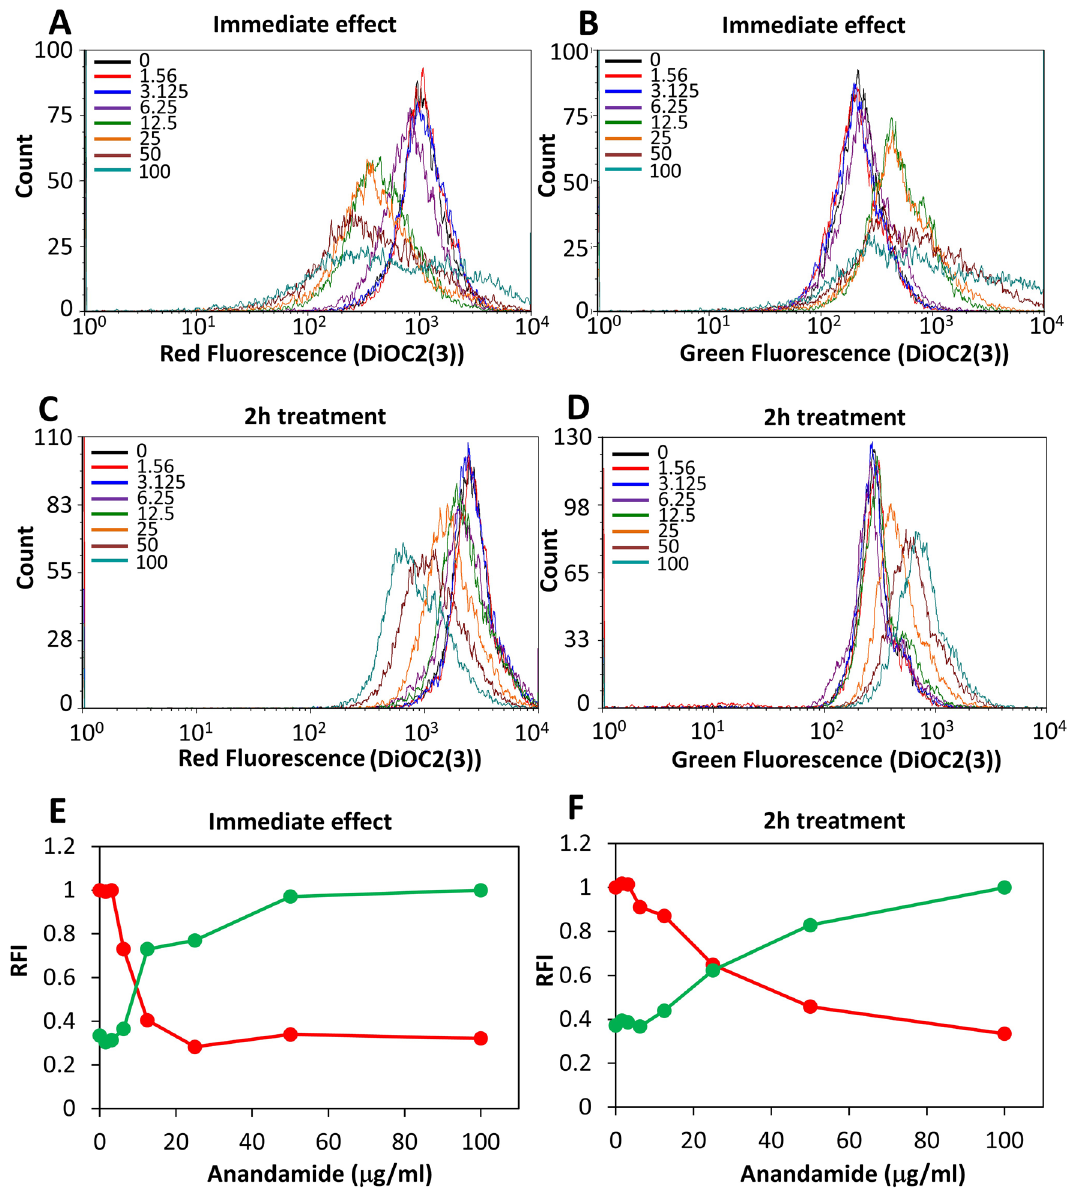
Figure 8. AEA causes an immediate drop in membrane potential that was partially relieved after 2 h. ( A – D ) The membrane potential was measured using the DiOC2(3) dye on flow cytometry immediately after adding AEA ( A , B ) and after 2 h treatment with AEA ( C , D ). Red fluorescence is an indication for the strength of the membrane potential. ( E , F ) are summaries of the relative fluorescence intensity (RFI) of the red (red lines) and green (green lines) fluorescence for the immediate AEA effect ( E ) and after 2 h treatment with AEA ( F